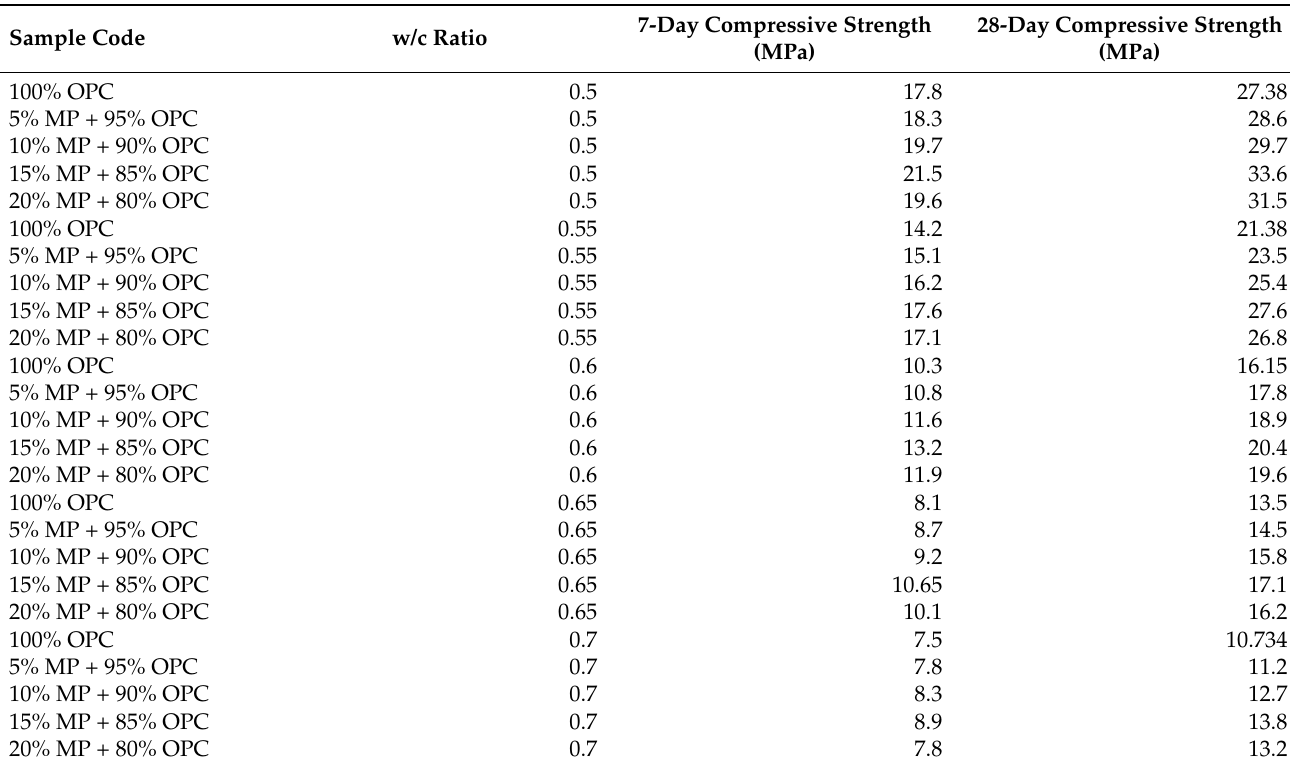
Table 3. Variation of 7-day and 28-day compressive strength with W/CM at various MP